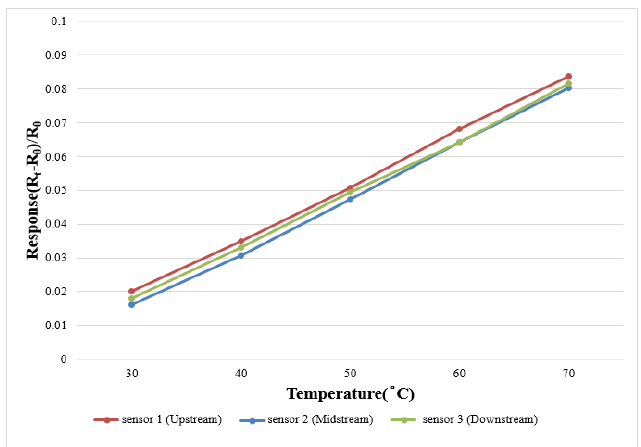
Figure 5. Temperature correction curve.